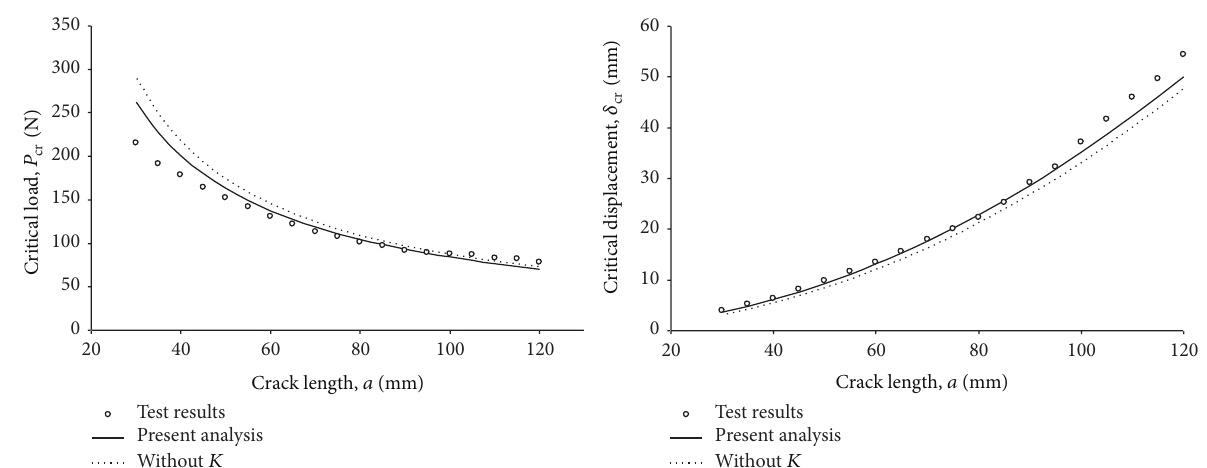
) and the corresponding displacement (𝛿 ) cr cr